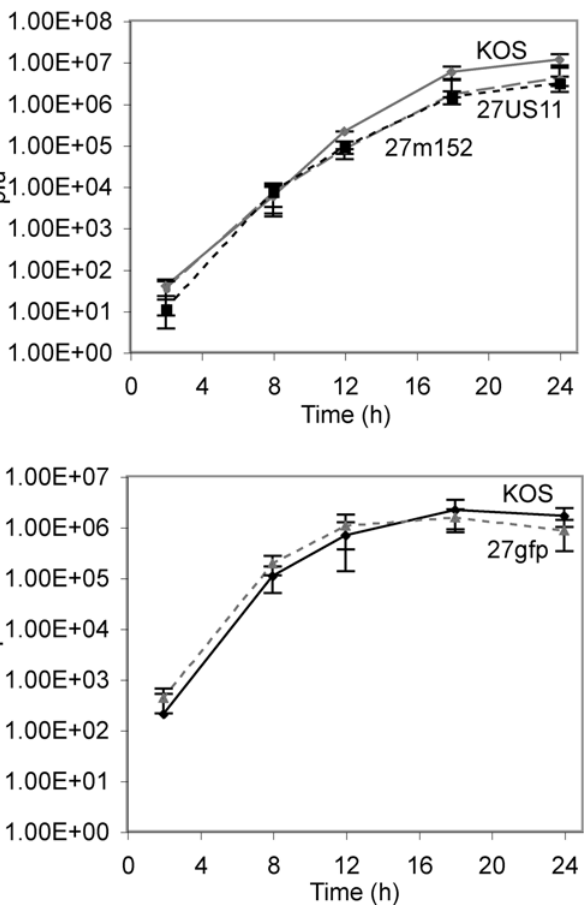
Figure 4. Single-Step Growth Kinetics of rHSVs Are Similar to KOS Vero cells were infected at an MOI of 5:1 with KOS plus (A) 27m152 or 27US11, or (B) 27gfp. Cells and supernatants were harvested at indicated times and viral titers were determined on vero cells. DOI: